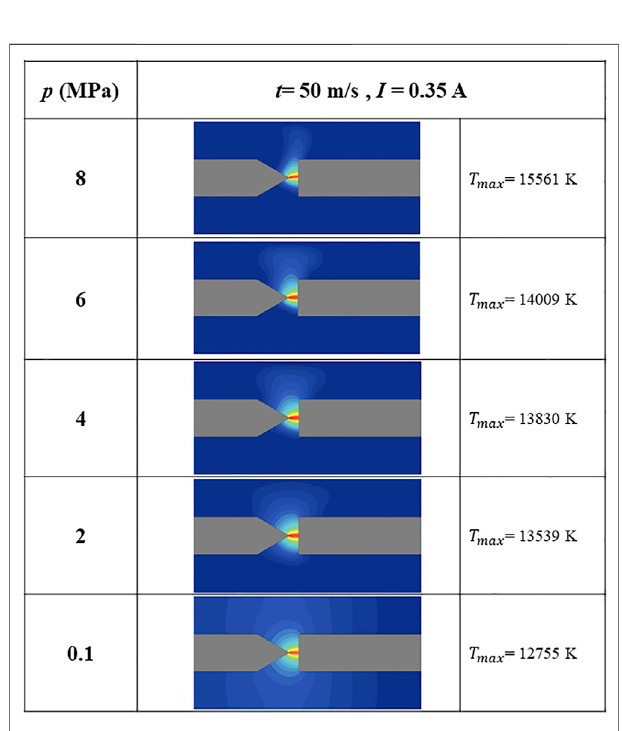
FIGURE 8 | The discharge temperature comparison for the entire pressure range. ( t (cid:2) 50 ms, I (cid:2) 0.35 A).